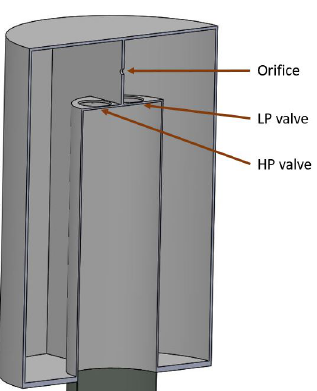
Figure 5. Section view of the symmetry plane of the Tupperwave device.